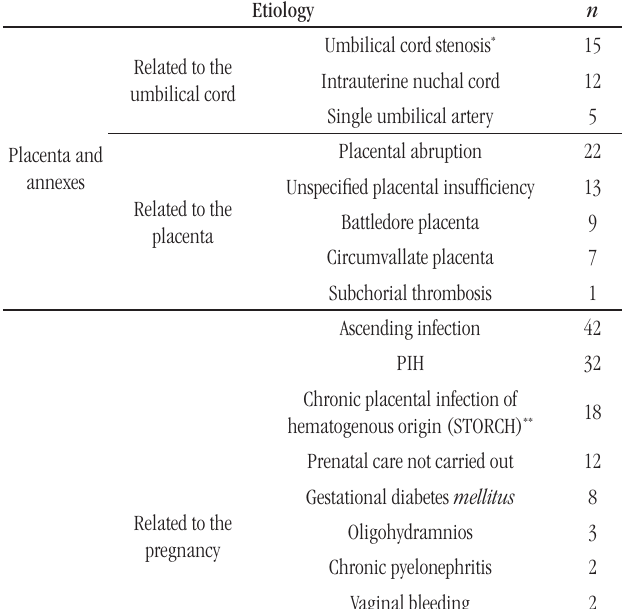
taBLE 2 − Etiology of the fetal death indicated in the